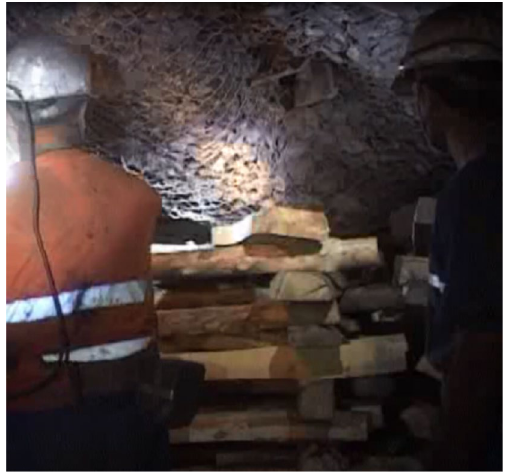
Figure 3. Severe roof displacement in the tailgate roadway at Tabas